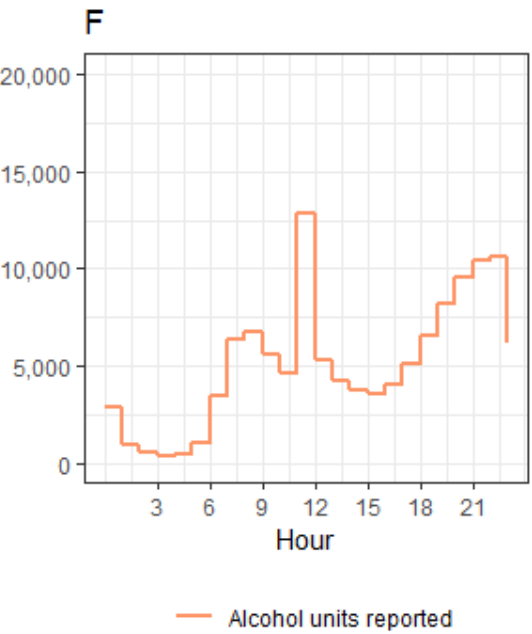
Figure 3. Frequency distributions of when alcohol-free days and alcohol units are recorded during the